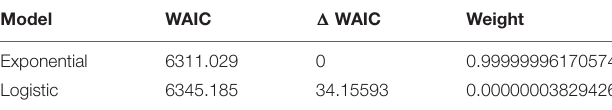
TABLE 2 | Model comparison